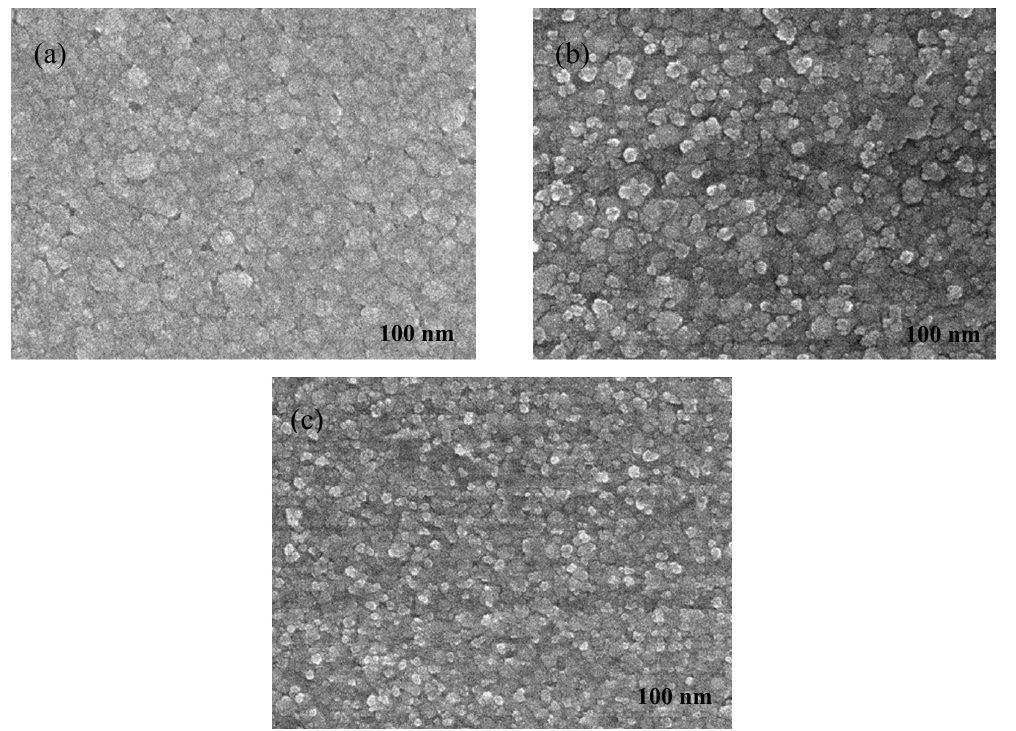
Figure 4. ( I / I m ) 2 vs. t / t m curves for the UPD-Mn in the electrolytes, with various terminated open circuit potential (OCP) times of ( a ) 60 s, ( b ) 40 s, and ( c ) 20 s.